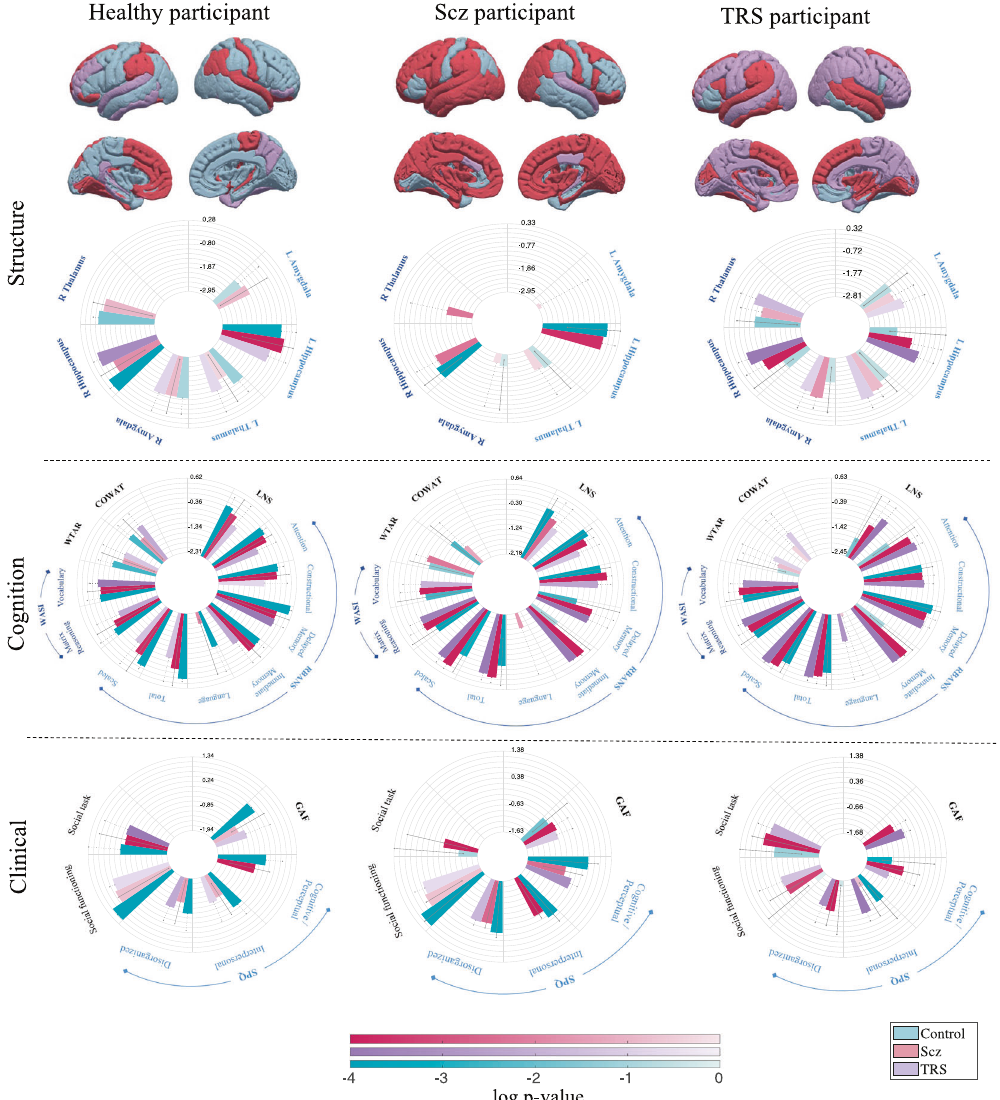
Fig. 1 Exemplar individual-centric af fi nity fi ngerprints. The cortical pattern describes maximal group af fi nity within each region. In the circular bar graphs, the variable-wise subcortical, cognitive and clinical af fi nity scores are plotted on the log-scale with 95% con fi dence intervals (absent bar: zero af fi nity score, dotted errorbar: zero lower CI). Shading on the bars is based on the log p-value quantifying score reliability. Within each variable, the largest bar corresponds to the group to which the individual shows strongest af fi nity, followed by the group with second-highest af fi nity and so Table 5. Classi fi cation accuracy of af fi nity-based and weighted KNN classi fi ers in the training, nested cross-validated and prediction datasets.